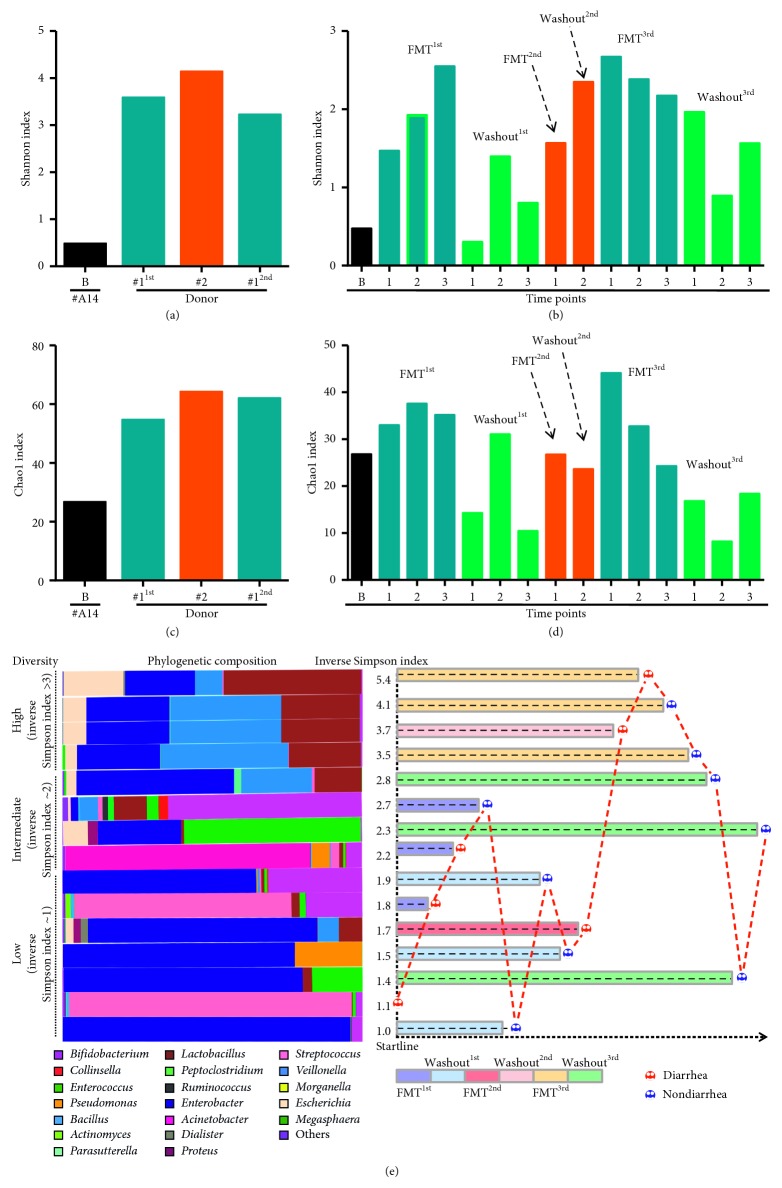
Dynamic changes in microbial diversity and richness during the entire FMT process. Microbial diversity was measured by the Shannon index at baseline (a) and the indicated time points (b) for both the FMT donors and the FMT recipient. Microbial richness was evaluated via the Chao1 index at baseline (c) and the indicated time points (d) during the entire FMT process. Recipient specimen collection points were rearranged according to the level of microbial diversity, and diarrhea status is labeled on the right. (e) The horizontal stacked bars on the left side represent the phylogenetic composition of the recipient at each sample collection time point. The hierarchy of microbial diversity was determined by the inverse Simpson index. Time bars are shown in the columns; the length of the time bar depends on the sequence of specimen collection.